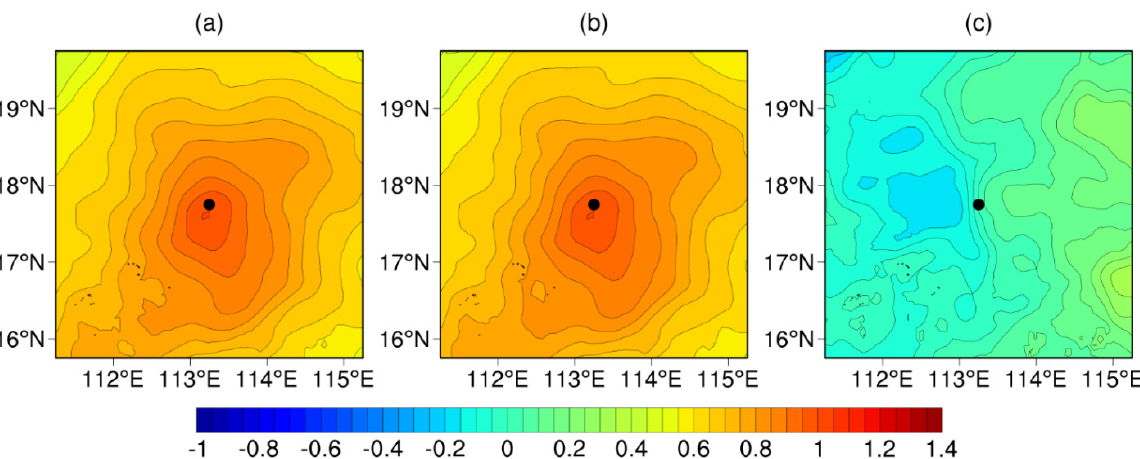
Figure 6. Distribution of the gain for group B on 1 January 2015, and the black dot in the figure is the observation point: ( a ) Kalman gain 𝐾 at moment 𝑡 in the EnOI scheme; ( b ) Kalman 𝐾 (cid:2868) at mo- ment 𝑡 in the EnOS scheme; ( c ) gain 𝐾 (cid:2869) acting at moment t in the EnOS scheme at historical mo- ment 𝑡 − 1 .